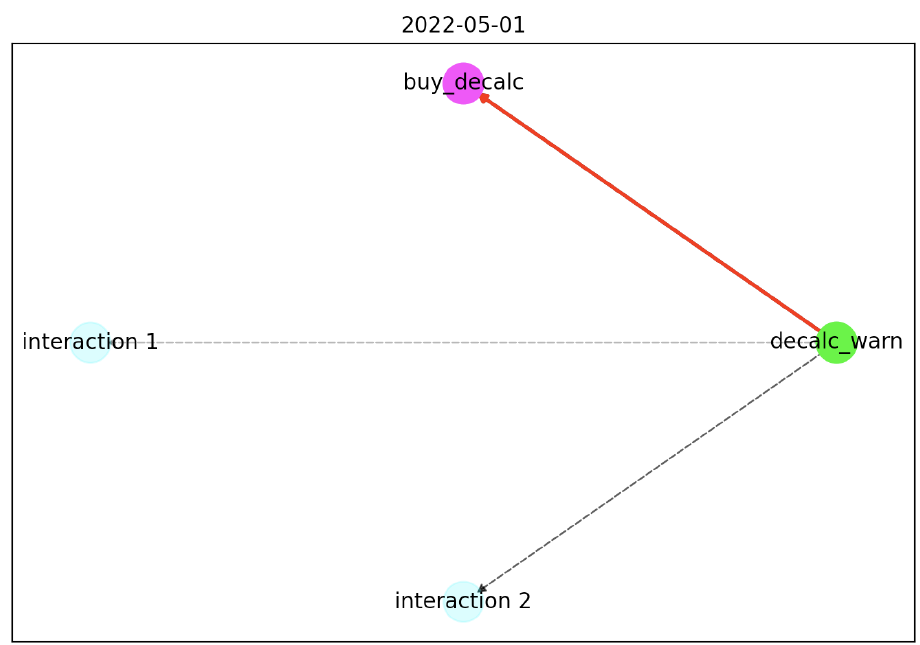
Figure 7. Example: Behavior graph after 4